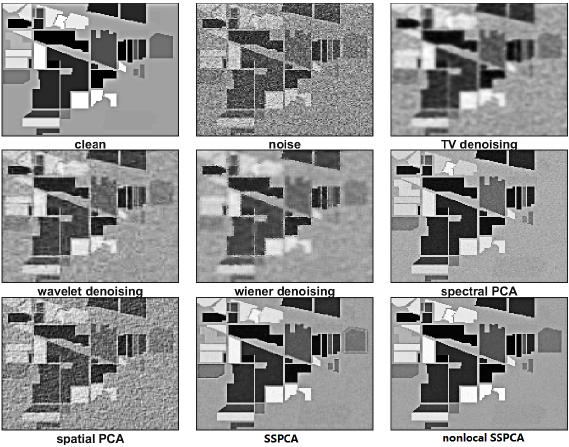
Figure 4. Denoising results achieved by different methods, on band 50 of simulated